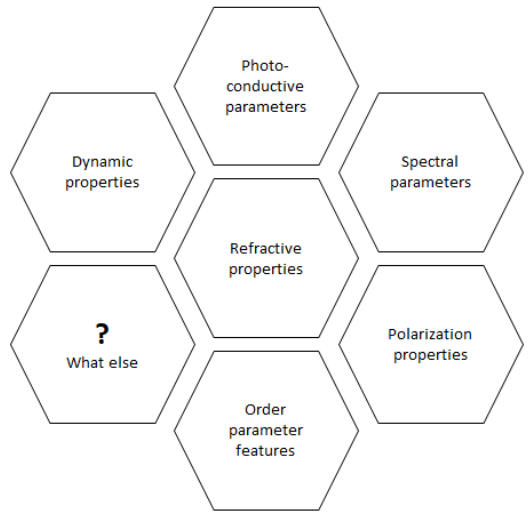
Figure 1. The qualitative (model) representation of the relationship between the refractive parameters and other important characteristics of the materials.